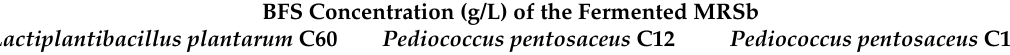
Table 4. Minimal inhibitory concentration (MIC) and minimal fungicidal concentration (MFC) of bacterial-free supernatant (BFS). MRS broth (MRSb) and meat broth (MB10) were fermented by LAB for 48 h at 37 ◦ C and centrifuged to obtain the